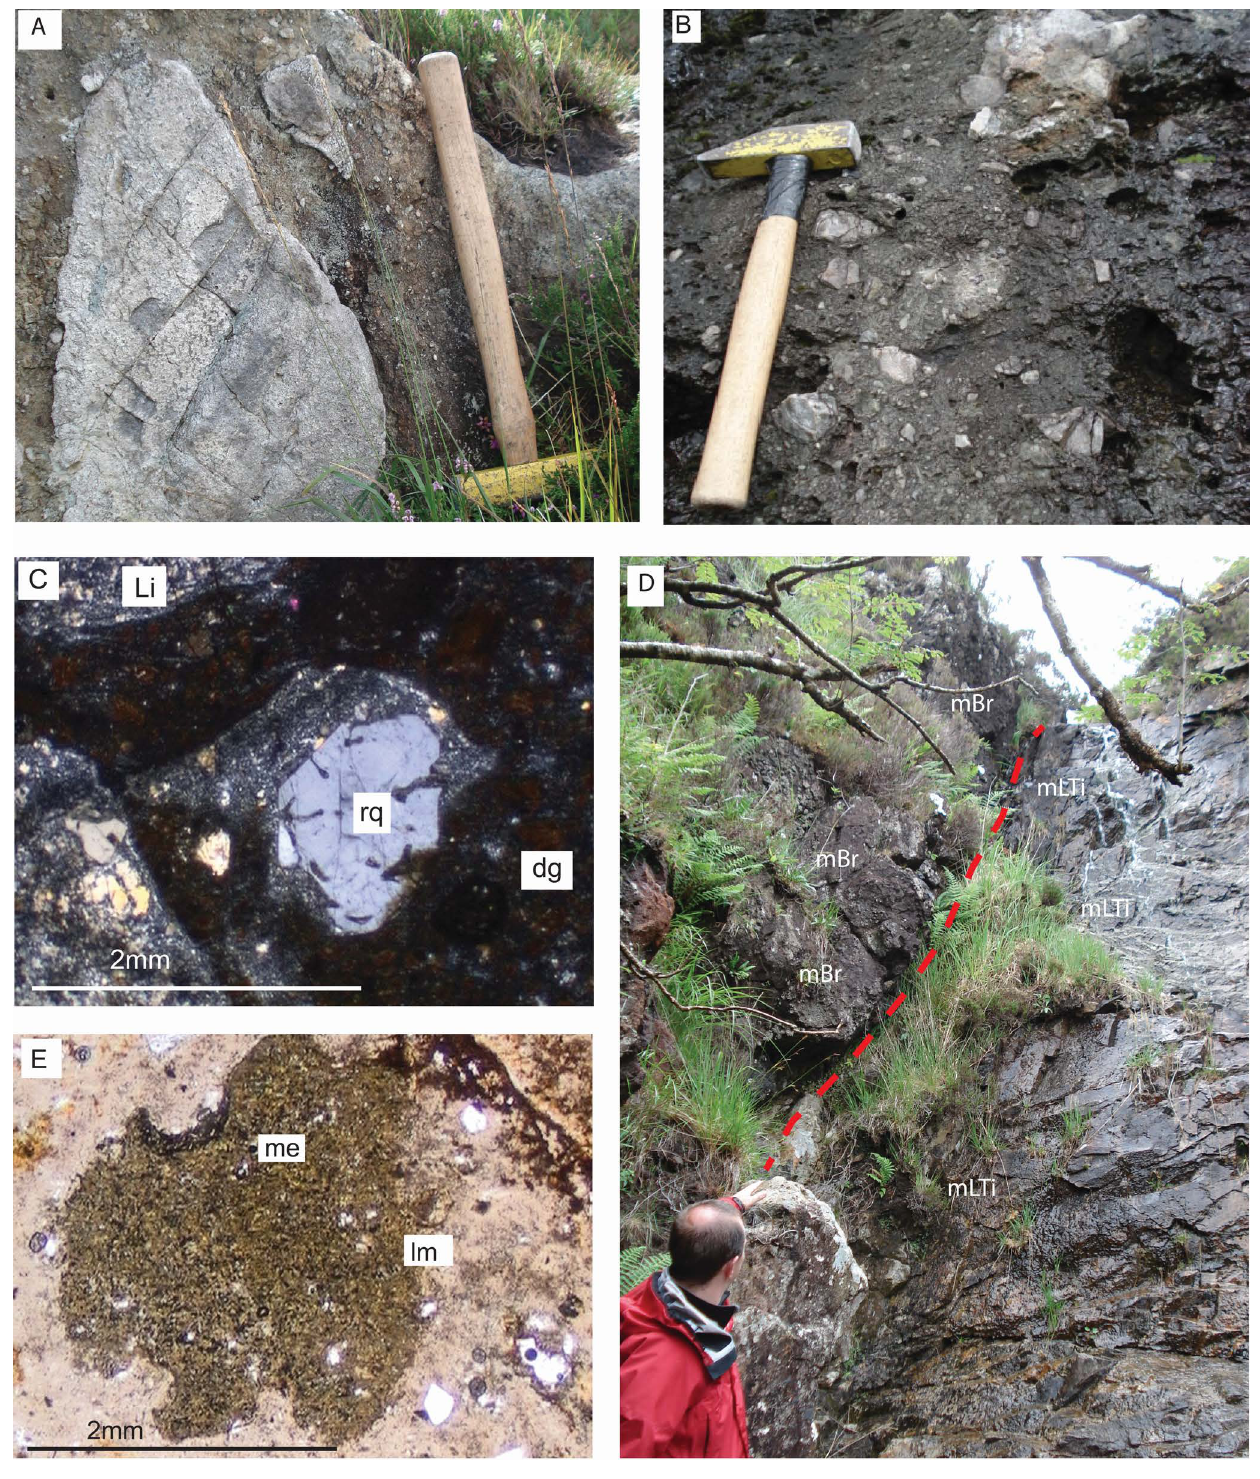
Figure 6: Field and petrographic characteristics of massive breccia (mBr) and massive lapilli tuff (mLT) [A] Quartzite block (hammer shaft 40 cm length) within matrix supported mBr at Cnoc nan Uan (log 9, 9 m: Supplementary Material 1). [B] Matrix supported ungraded mLT with an ash-granule grade matrix containing weathered in lithic-lapilli moulds (right of hammer). Note mechanical fracture of subangular quartzite lithic lapilli to right of hammer (log 16, 630m height, see Supplementary Material 1). [C] Secondary resorbed quartz (rq) within mLT overgrowing pre-existing lithics (Li). Devitrified brown glass (dg) is a common matrix feature. XP (log 13, 19 m height: Supplementary Material 1). [D] Matrix supported mBr in Allt nan Suidheachan (log 16, 500 m height, see Supplementary Material 1) containing blocks of arkosic sandstone, and incipiently welded mLTi. [E] Type III rounded matrix mafic enclave (me) [Troll et al. 2000; 2004] with highly irregular lobate margins (lm) in mLT (see log 18, 220 m height: Supplementary Material